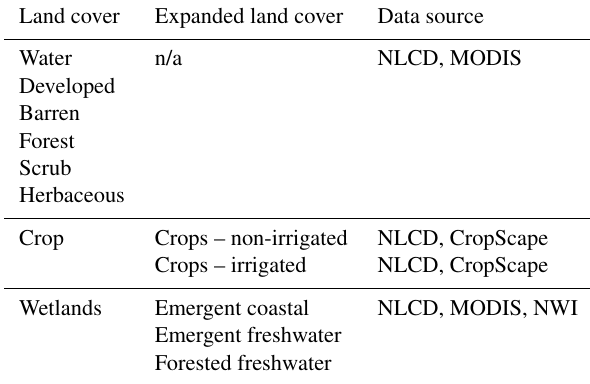
Table 1. Land cover and data sources. The blended land cover prod- uct comprises the National Land Cover Database (NLCD) and Mod- erate Resolution Imaging Spectroradiometer (MODIS). The crop category is enhanced with CropScape and the wetland category with the National Wetland Inventory (NWI) to identify areas dominated by land cover types with additional classes added for types with expected CH 4 source